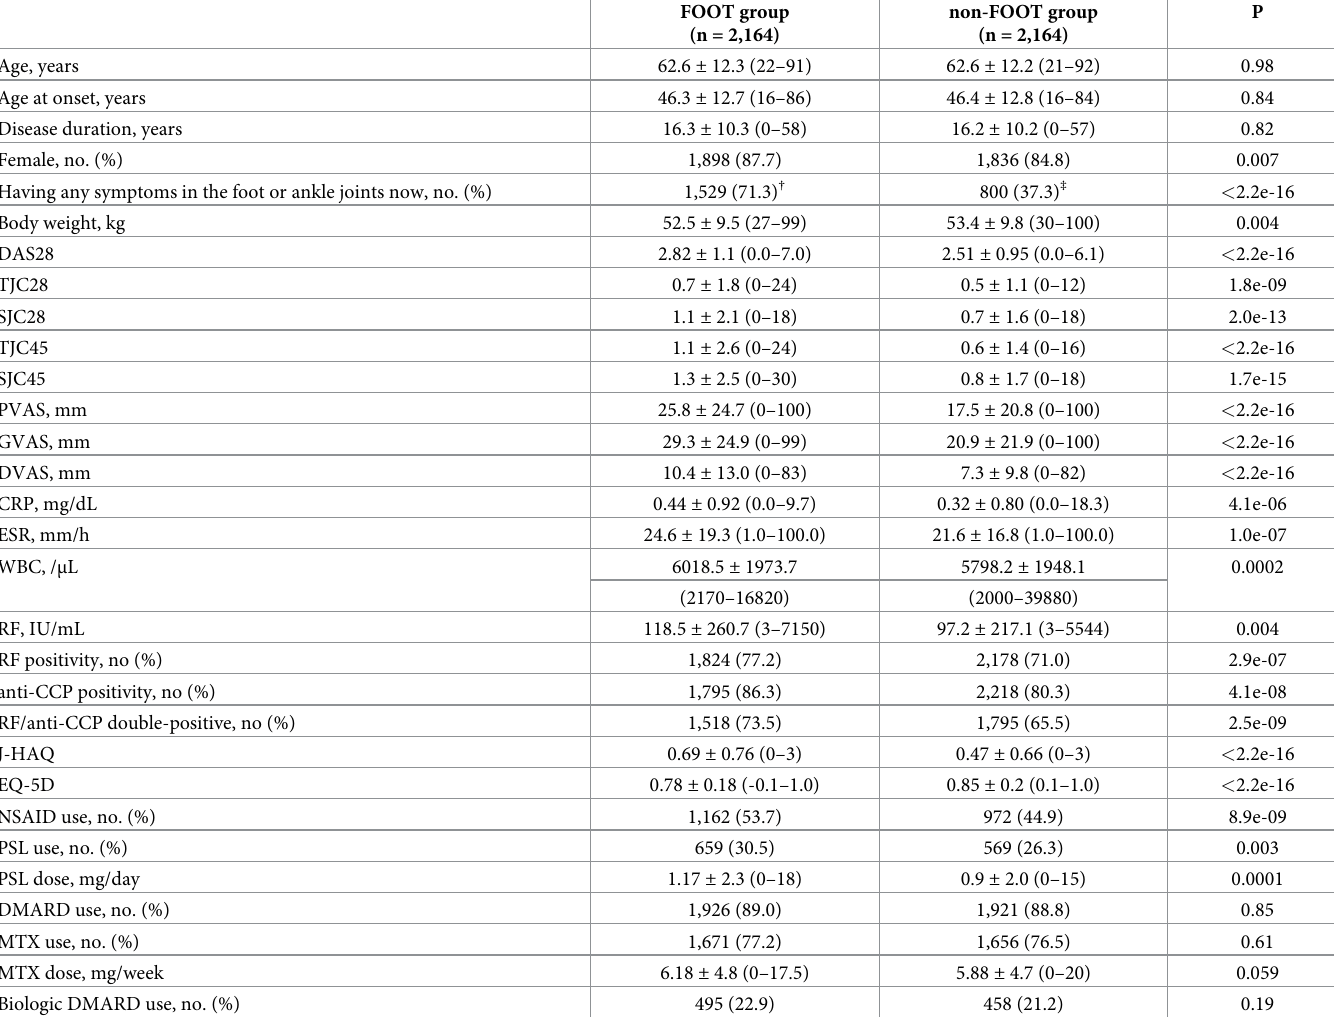
Table 2. Comparison of clinical features and outcomes in the IORRA survey conducted in April 2016 between the patients whose debut joint was the foot or ankle (FOOT group) and patients whose debut joint was another joint (non-FOOT group). (cid:3)